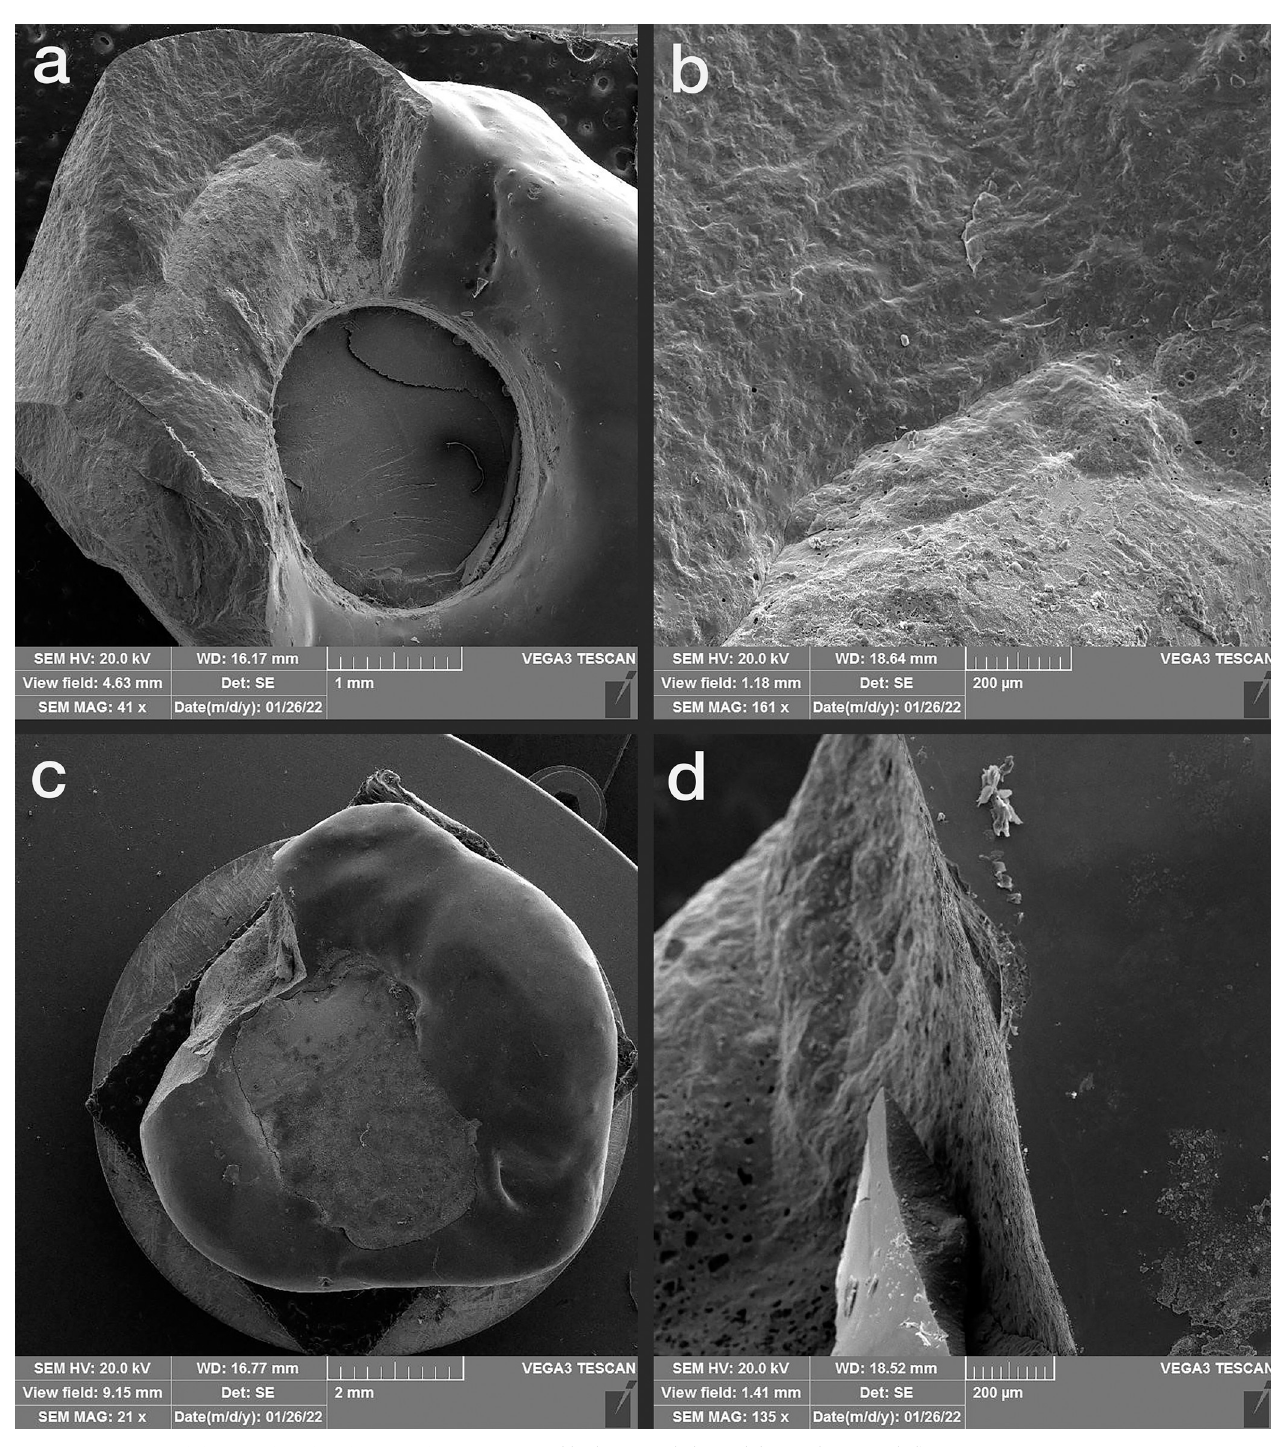
Fig 5. SEM images of the porcelain-fused-to-metal specimen. a and b: thermocycled, c and d: non-thermocycled).